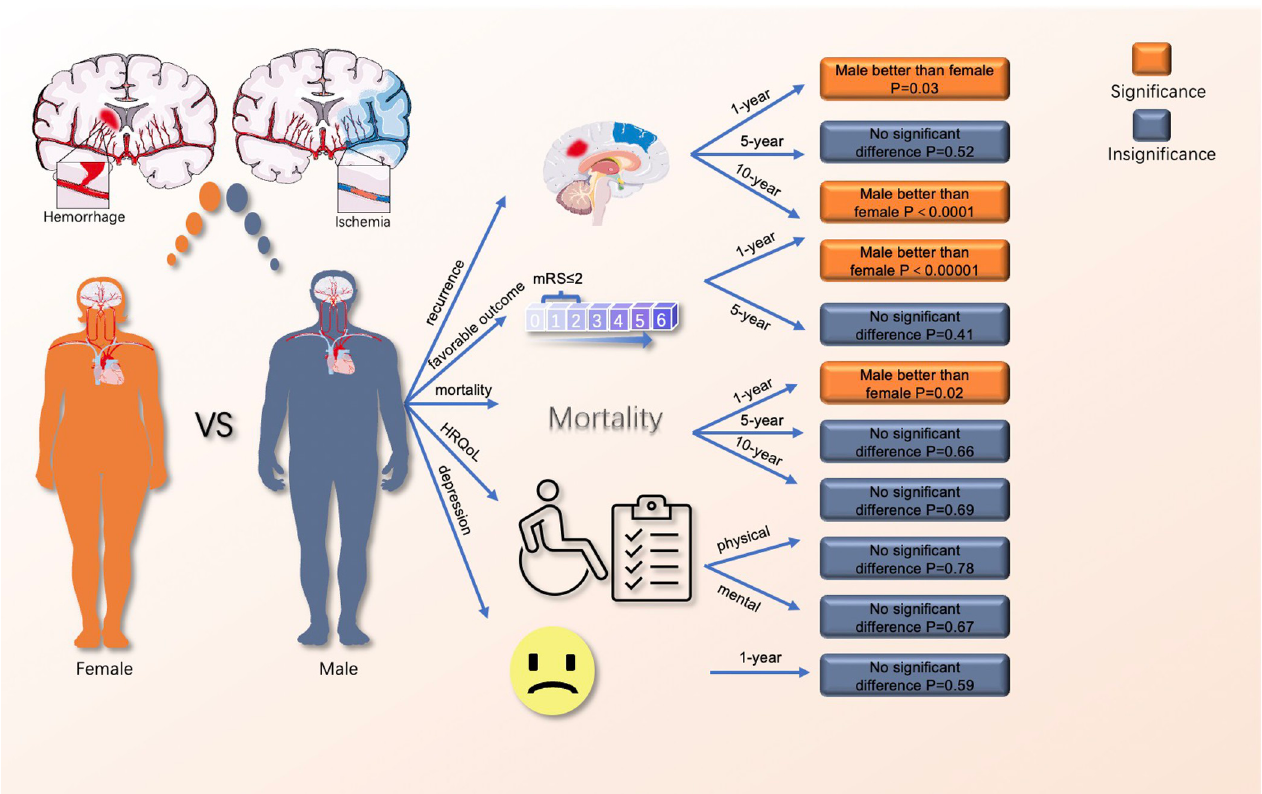
Fig 4. The comparison of long-term outcomes between males and females. Parts of the Fig 4 (such as human outlines and brain images) were drawn by using pictures from Servier Medical Art. Servier Medical Art by Servier is licensed under a Creative Commons Attribution 3.0 Unported License (https://